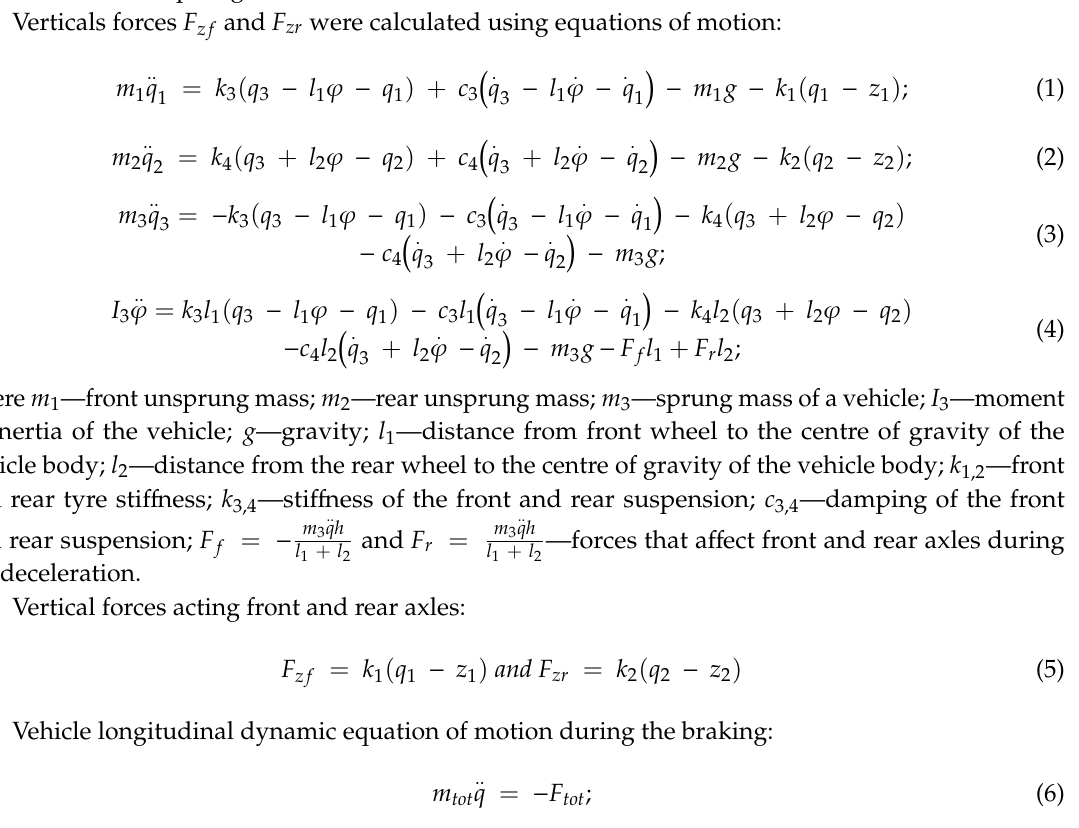
Table 1. Parameters for mathematical model (MM). Parameter Numerical Value Unsprung mass of front wheels, m 1 [ kg ] 60 Unsprung mass of rear wheels, m 2 [ kg ] 40 Vehicle body mass, m 3 [ kg ] 1160 (cid:104) (cid:105) 1761.4 kgm 2 Vehicle body inertia moment, I 3 (cid:104) (cid:105) 9.81 Gravitational acceleration, g m/s 2 Sti ff ness of front wheels, k 1 [ N/m ] 2 · 10 5 Sti ff ness of rear wheels, k 2 [ N/m ] 2 · 10 5 Sti ff ness of front suspension, k 3 [ N/m ] 2 · 24,236.5 Sti ff ness of rear suspension, k 4 [ N/m ] 2 · 16,965.5 Damping of front suspension, c 3 [ Ns/m ] 2 · 2726.6 Damping of rear suspension, c 4 [ Ns/m ] 2 · 1908.6 Distance from front wheel to the centre of vehicle body mass, a 1 [ m ] 1.37 Distance from the rear wheel to the centre of vehicle body mass, a 2 [ m ] 1.33 Weight of centre of vehicle body mass 0.6 Wheel radii, r [ m ] 0.3 (cid:104) (cid:105) 2 · 1.155 Front axle moment of inertia, I f kgm 2 (cid:104) (cid:105) 2 · Rear axle moment of inertia, I r kgm 2